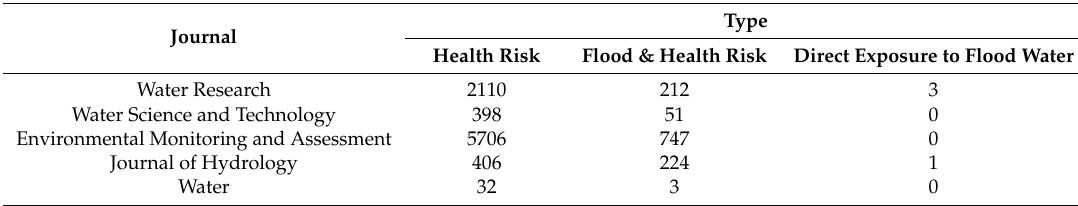
Table 2. Research papers connecting flooding and health risk in select journals.